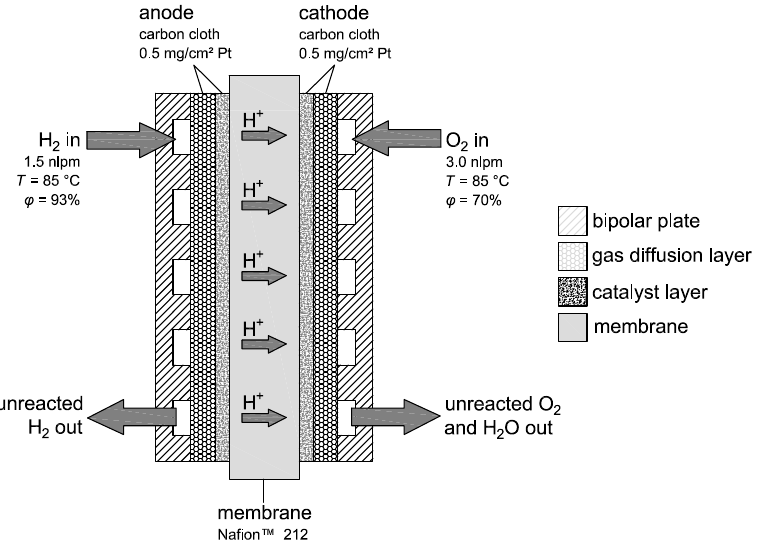
Figure 6. Profile of a proton exchange membrane fuel cell with the employed